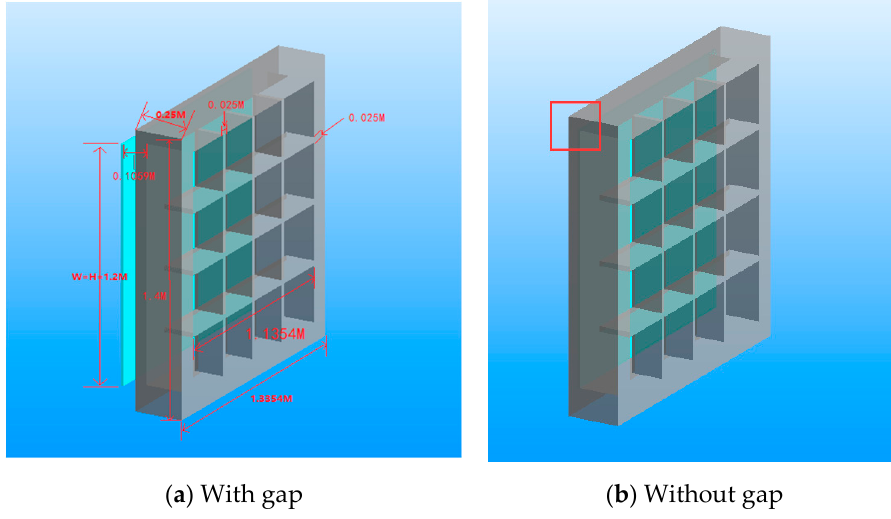
Figure 19. Mesh-shaped shading device.